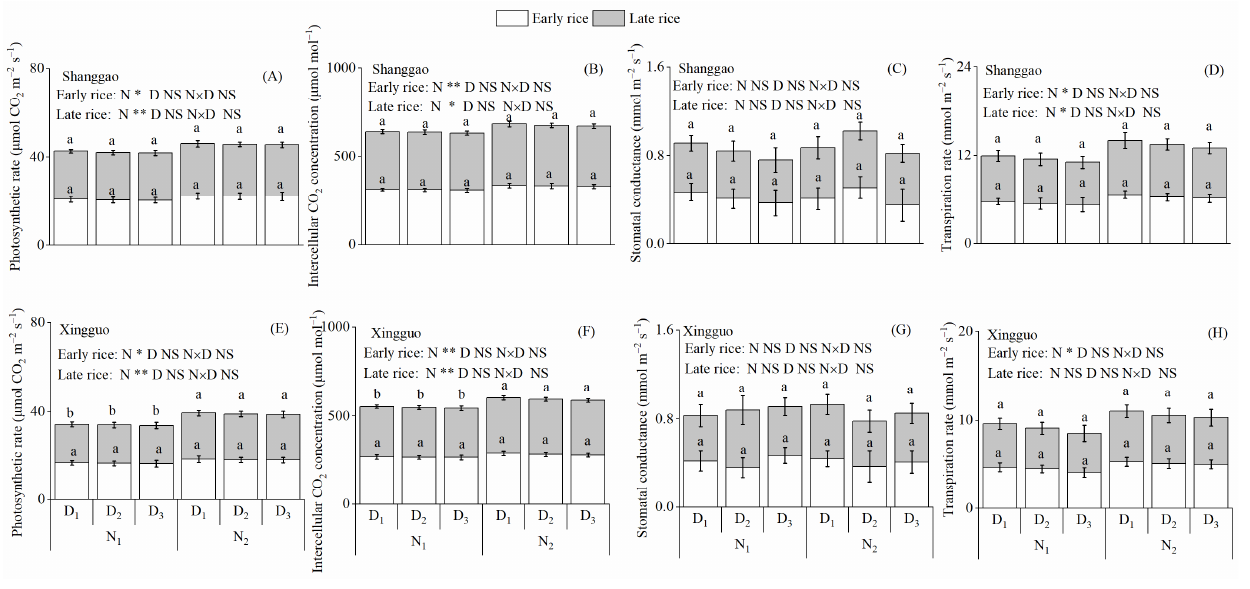
Figure 5. Photosynthetic characteristics of double cropping rice ( A – H ) response to the N rate and plant density in two different ecological regions in 2018. N 1 and N 2 represent 120 and 150 kg ha -1 for early rice and N 1 and N 2 represent 120 and 165 kg ha -1 for late rice. D 1 , D 2 and D 3 represent 86, 143 and 200 plants per m 2 for early rice and D 1 , D 2 and D 3 represent 57, 114 and 172 plants per m 2 for late rice. Values followed by different lowercase letters are significantly different at the 0.05 level. NS, * and ** represent no significant difference and significant difference at the 5% and 1% levels.